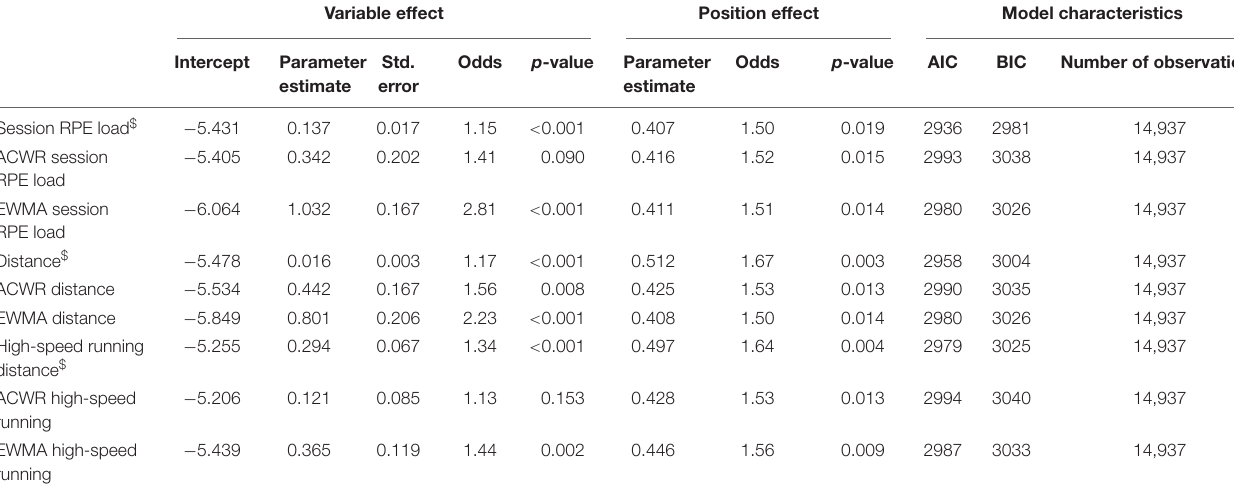
TABLE 3 | Multilevel model characteristics (with an equal n for all